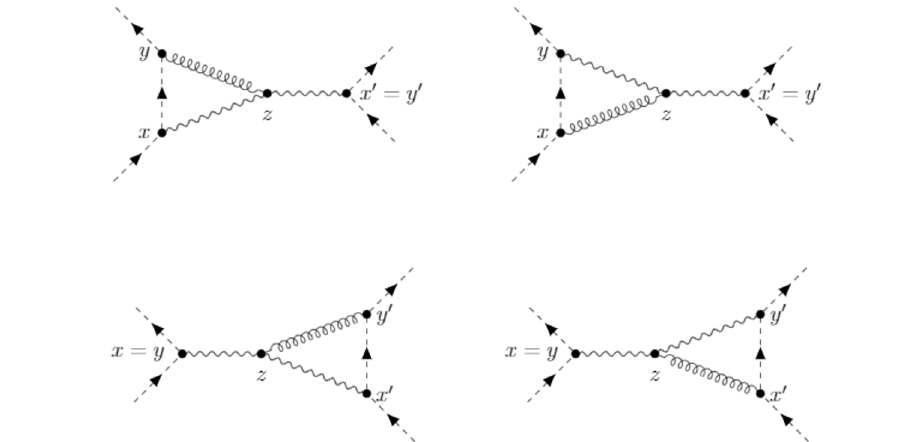
Figure 6 . These diagrams show the contributions from correlations between the source (primed) or observer (unprimed) and the force carrier. Dashed lines represent massive scalars, wavy lines represent photons and curly lines represent gravitons. These graphs have the same topology as Bjerrum-Bohr’s Diagram 6